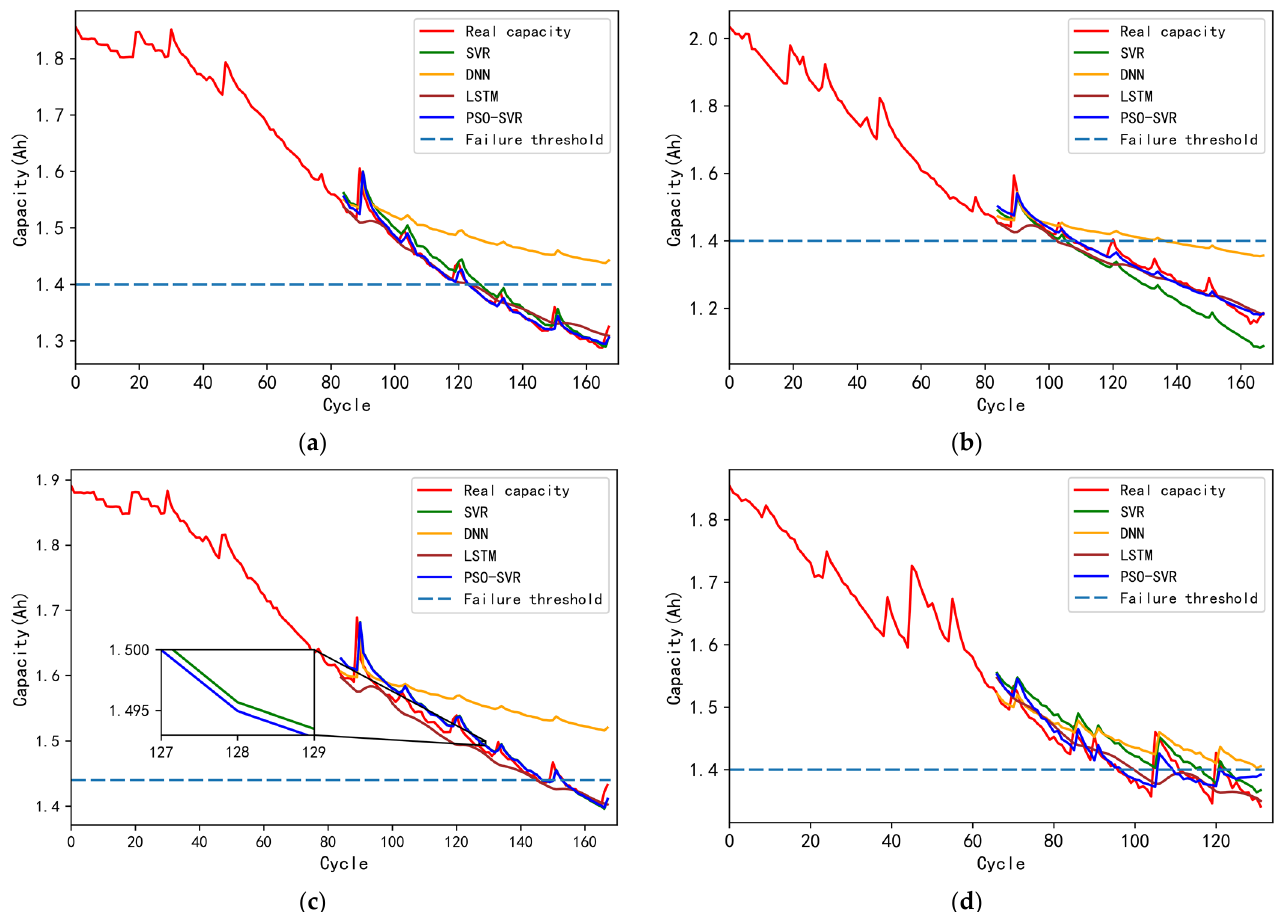
Figure 7. Prediction results based on SVR, DNN, LSTM and PSO–SVR using the first 50% of the total